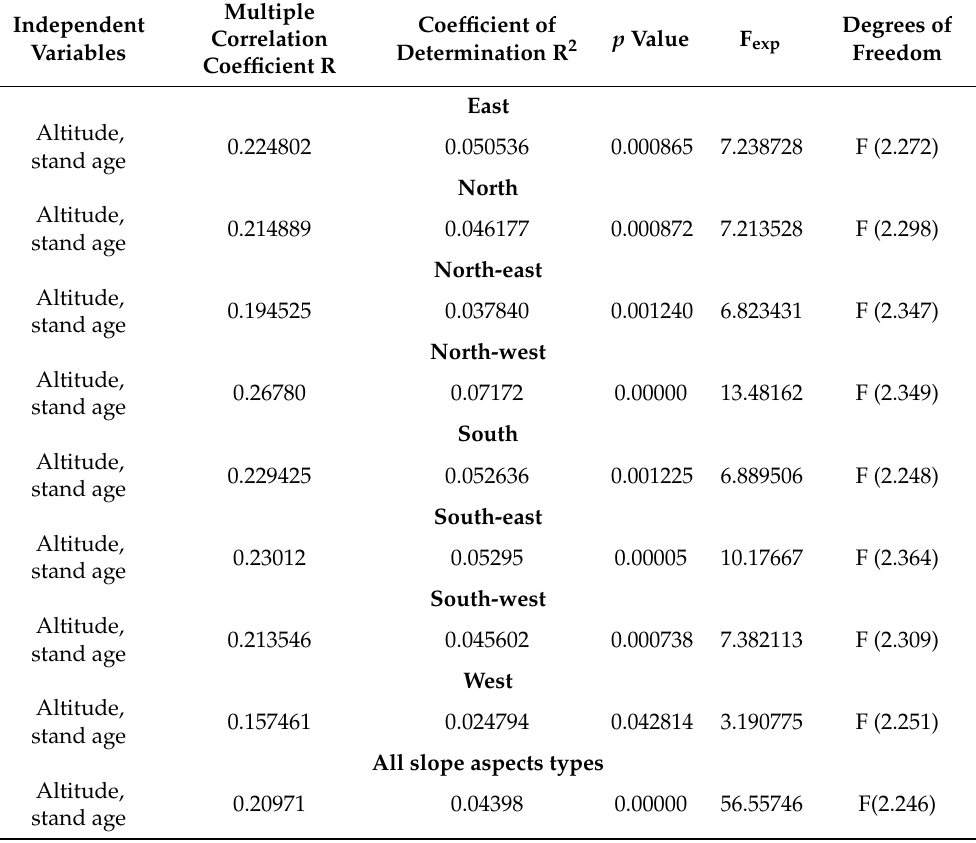
Table 5. Multiple linear regression between altitude, tree age and soil organic matter content for Ao horizon for dystric cambisol.